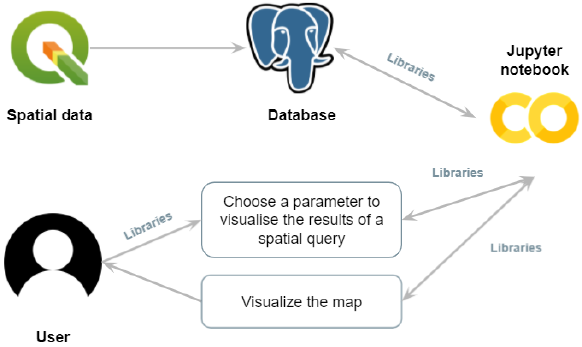
Figure 5 . The system architecture of Collaborative Emotional Mapping Project.